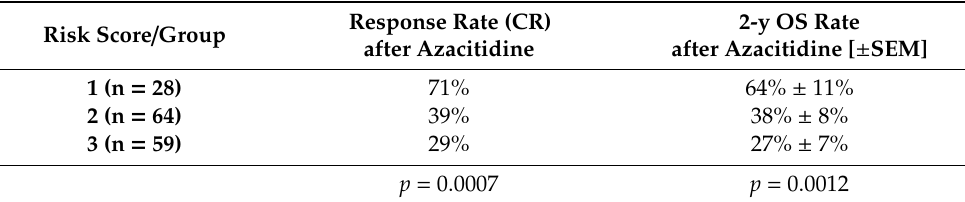
Table 4. Two-year overall survival and response rate of 151 patients with MDS, sAML, and de novo AML treated with azacitidine ± DLI for relapse after allo-HSCT according to the proposed scoring system. Response Rate (CR) 2-y OS Rate Risk Score / Group after Azacitidine after Azacitidine [ ± SEM] 1 (n = 28) 71% 64% ±